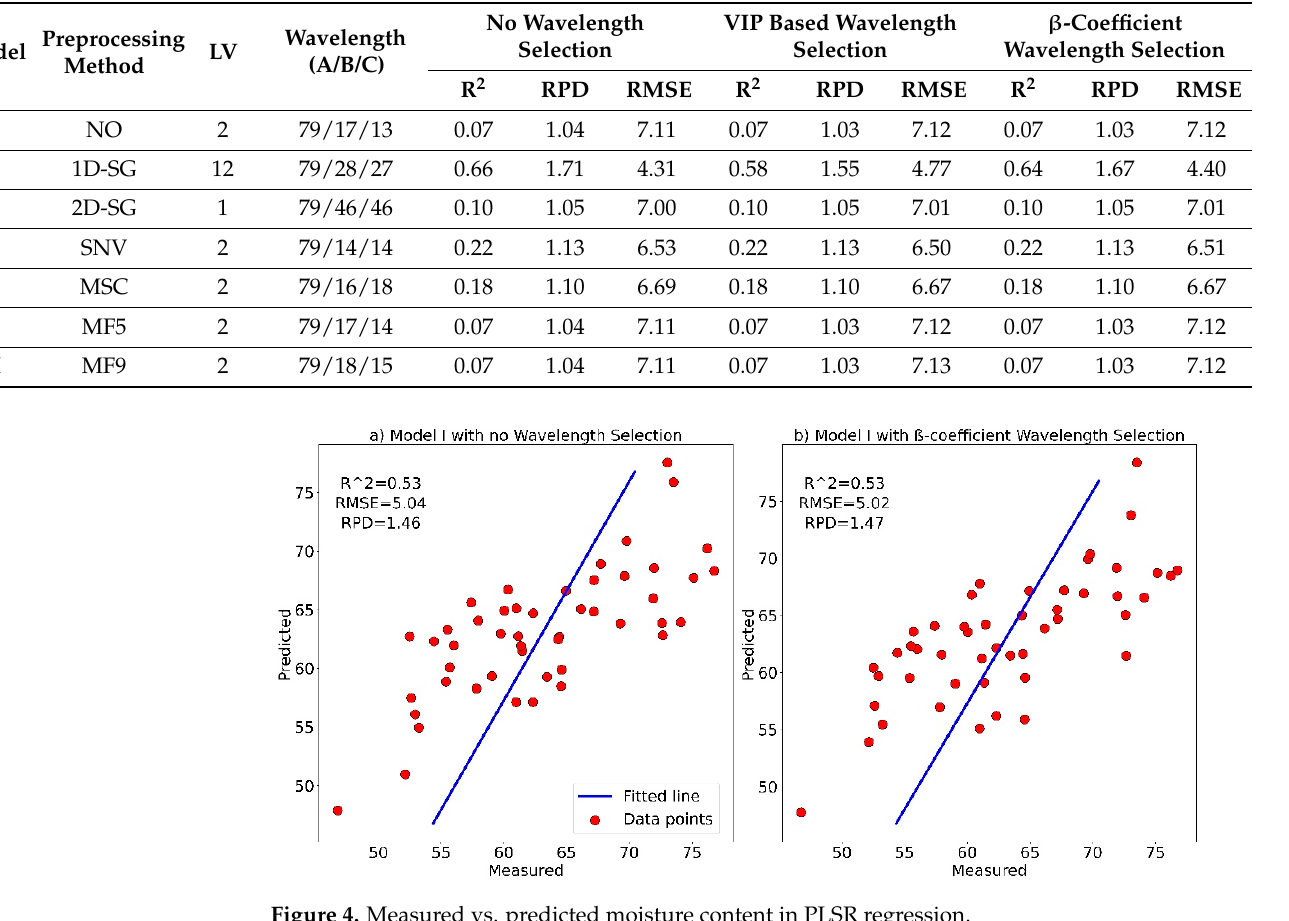
Table 2. The PLSR results when considering wavelengths between 732.53 and 969.63 nm (a total of 79 spectral bands).